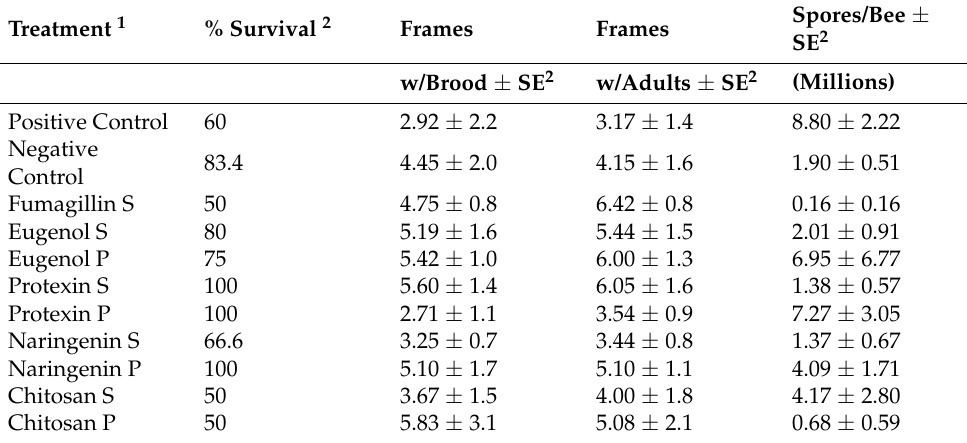
Table 5. Effect of fall 2017 treatments on percent overwinter survival, number of frames with brood or adult bees and number of N. ceranae spores per bee in the spring 2018 for colonies treated with the antibiotic fumagillin, prebiotics eugenol, naringenin or chitosan, or probiotic Protexin ® . Means are from 3 colonies for positive control, fumagillin S, eugenol P, chitosan S and chitosan P, 4 colonies for eugenol S and naringenin S, 5 colonies for negative control, Protexin ® S and naringenin P, and 6 colonies for Protexin ®